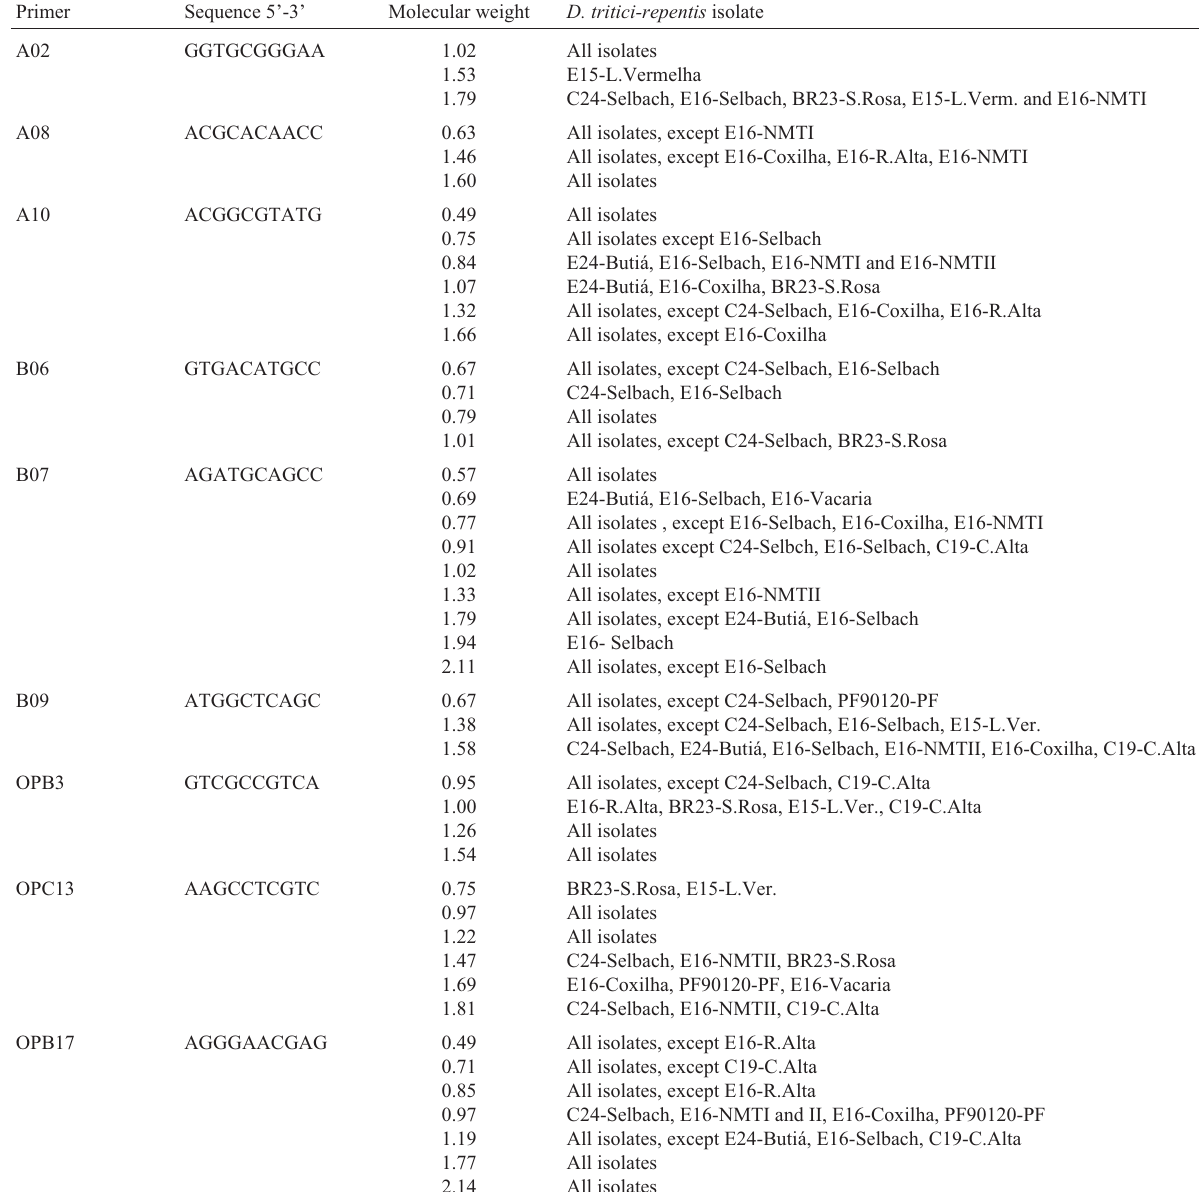
Table II - Sequence of the primers tested and the size in kilobases (kb) of the Drechslera tritici-repentis DNA fragments amplified.